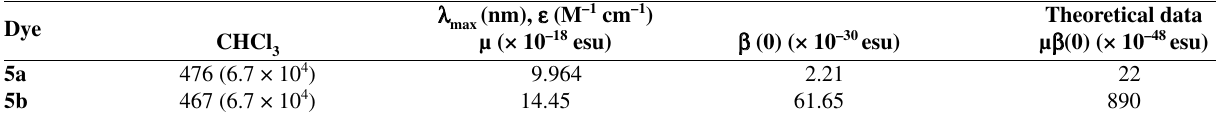
Table 2. Measured absorption spectral data and calculated microscopic nonlinear optical parameters of the synthesized dyes 5a and 5b Dye